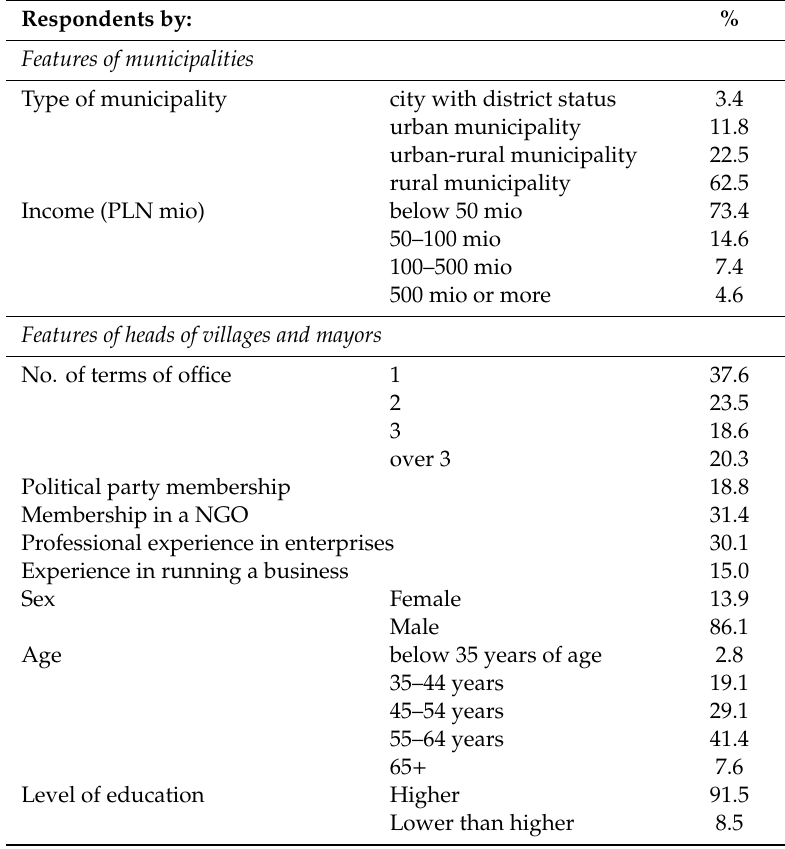
Table 2. Sample structure by selected features (n =